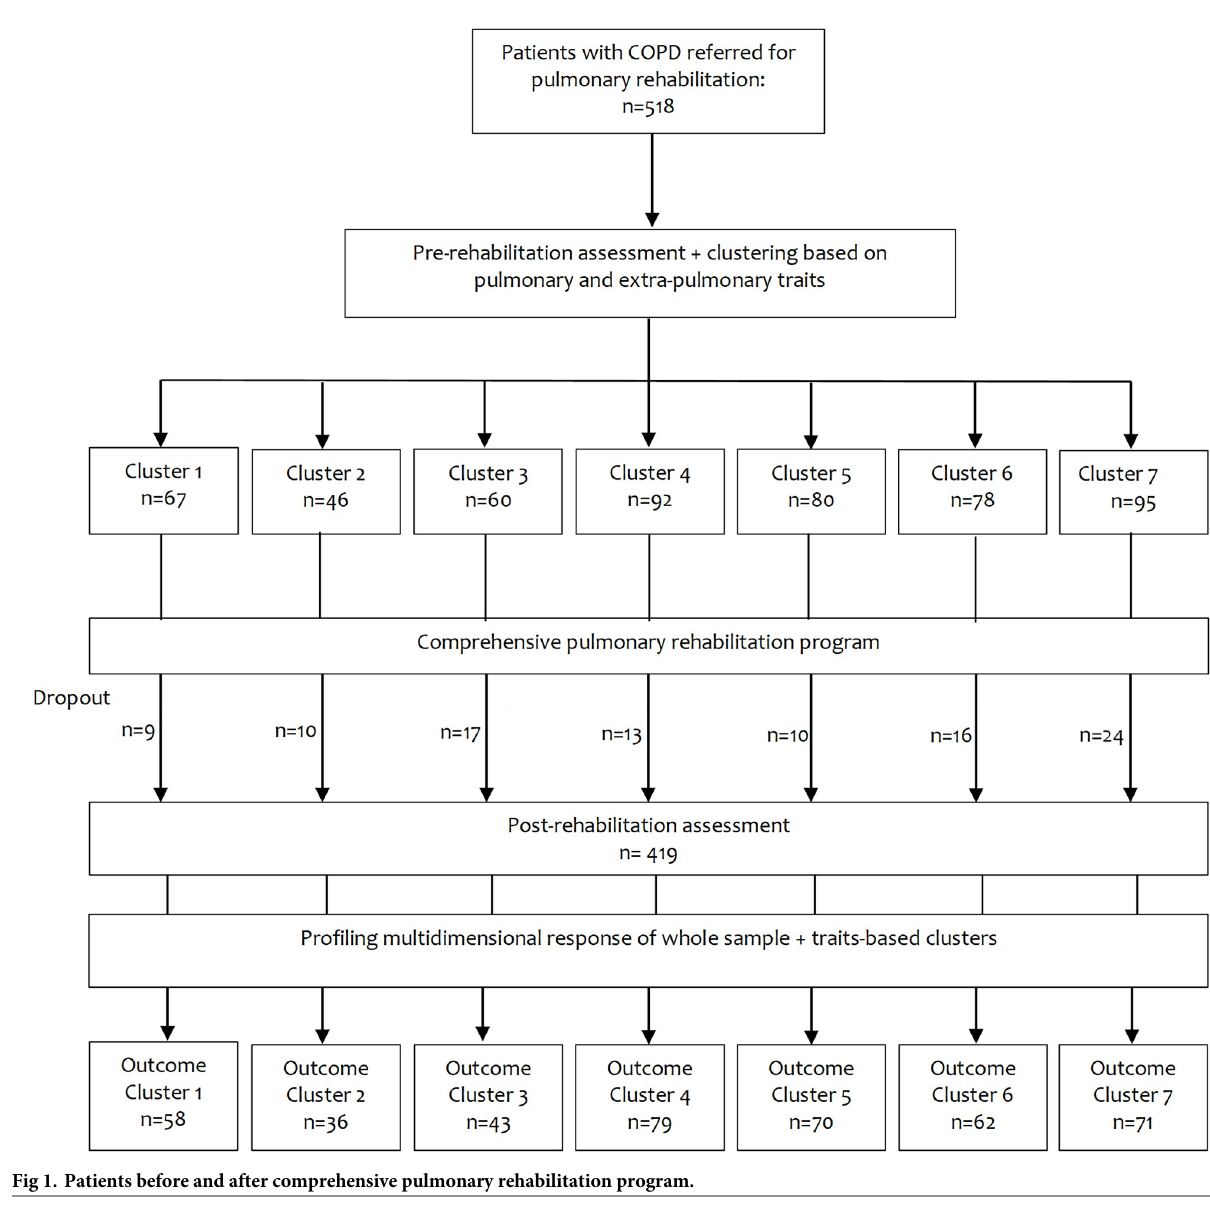
Fig 1. Patients before and after comprehensive pulmonary rehabilitation